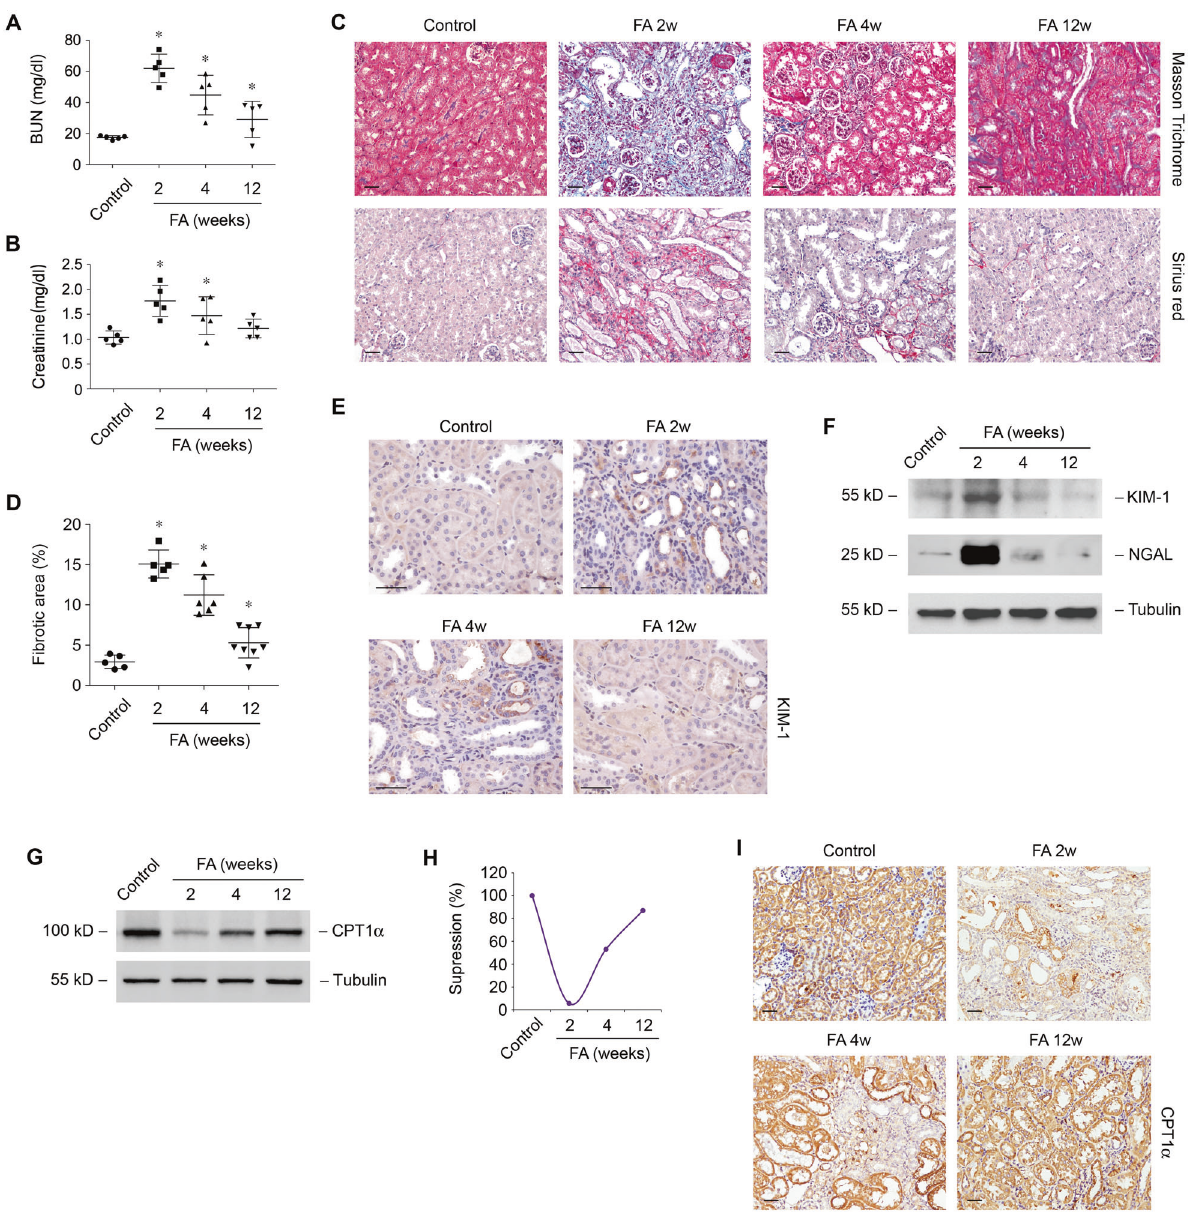
Fig. 1 Dynamic changes of CPT1 α during kidney injury and repair in folic acid nephropathy model. Changes of BUN ( A ) and creatinine ( B ) in groups as indicated. n = 5 for each group. * P < 0.05 versus control. C Representative images of mice kidney samples from groups as indicated stained with Masson trichrome and Sirius red. D Percentage of the fi brotic area in groups as indicated. n = 5 − 8 for each group. * P < 0.05 versus control. E Representative images of mice kidney samples immunostained with KIM-1. F Western blot analysis of protein expression of KIM-1 and NGAL in kidney samples from groups as indicated. G Western blot analysis of protein expression of CPT1 α in kidney samples from groups as indicated. H Graphic presentation of the relative abundance of CPT1 α in the folic acid model. I Representative images of mice kidney samples immunostained with CPT1 α . Scale bar, 50 μ